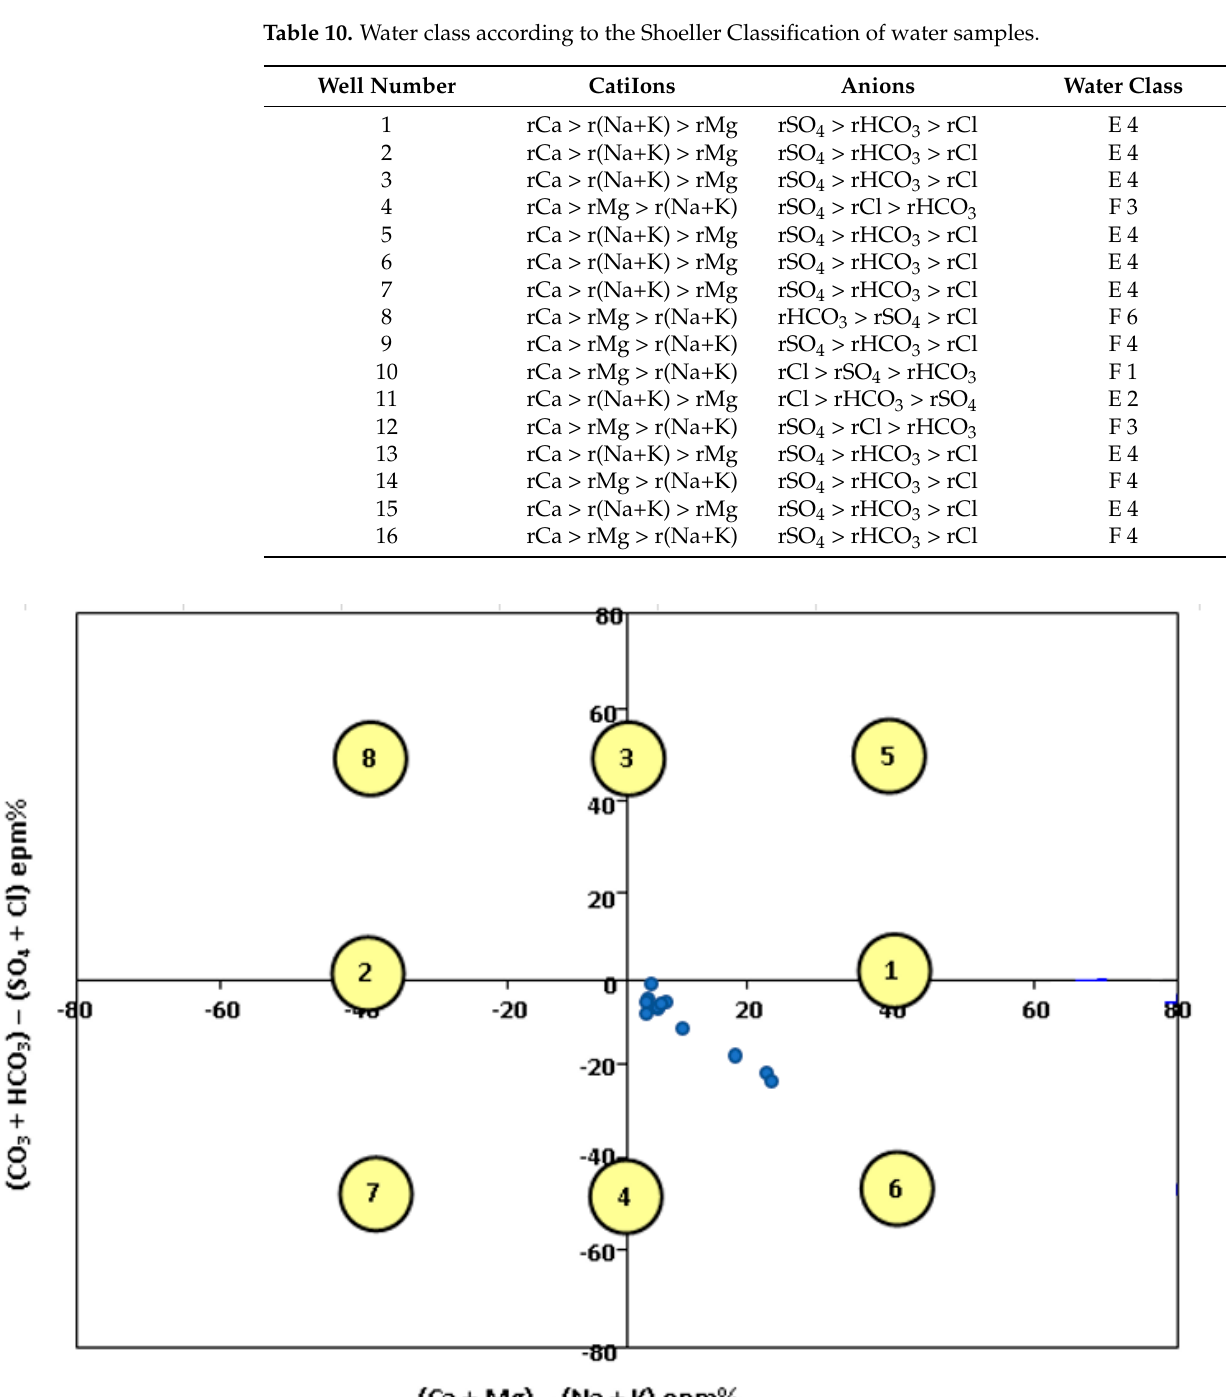
Figure 7. Water type according to the Chadha classification (1999) [30].